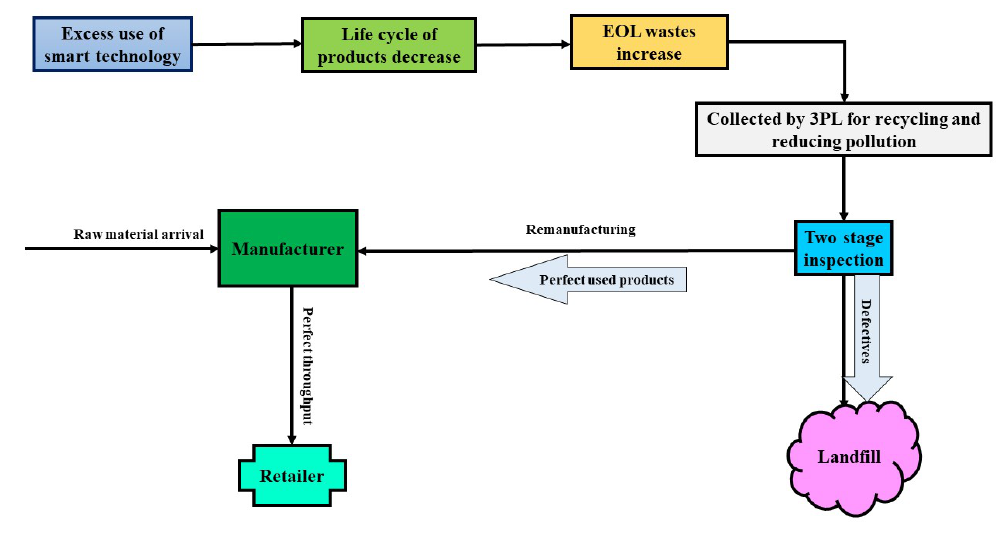
Figure 1. Problem